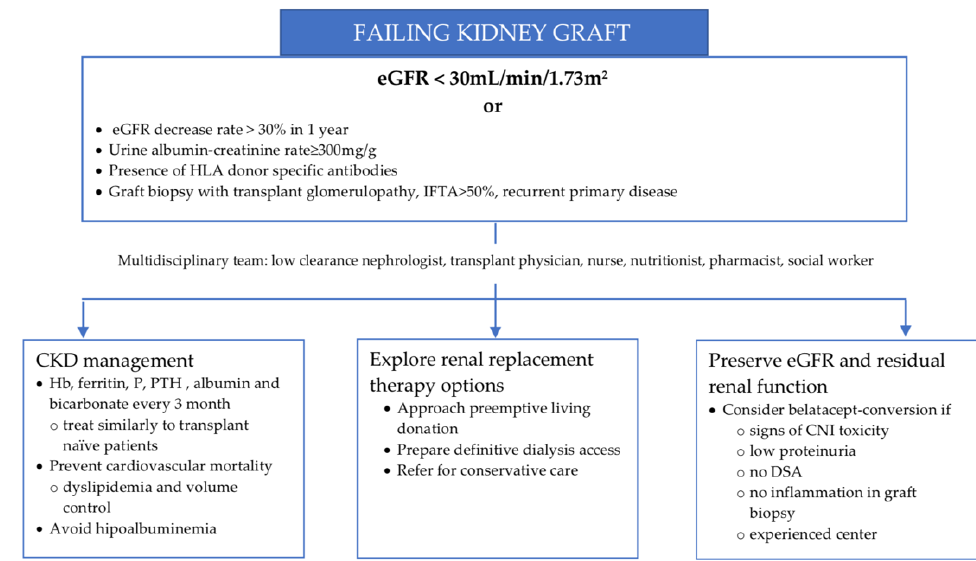
Figure 1. Managing the patient with a failing kidney graft. CKD—chronic kidney disease, CNI—calcineurin inhibitor, DSA—donor specific antibody, eGFR—estimated glomerular filtration rate, IFTA—interstitial fibrosis and tubular atrophy.